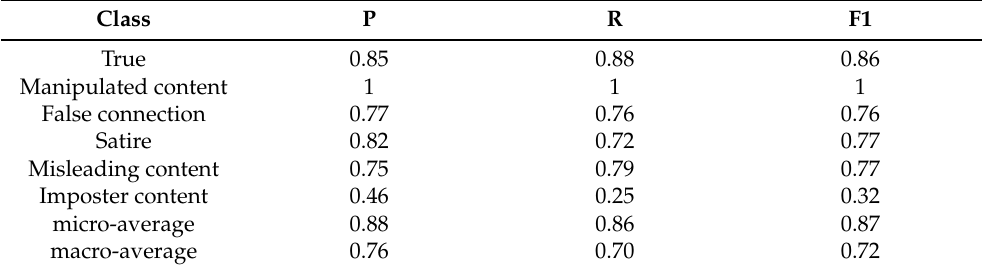
Table 10. Multimodal approach results.